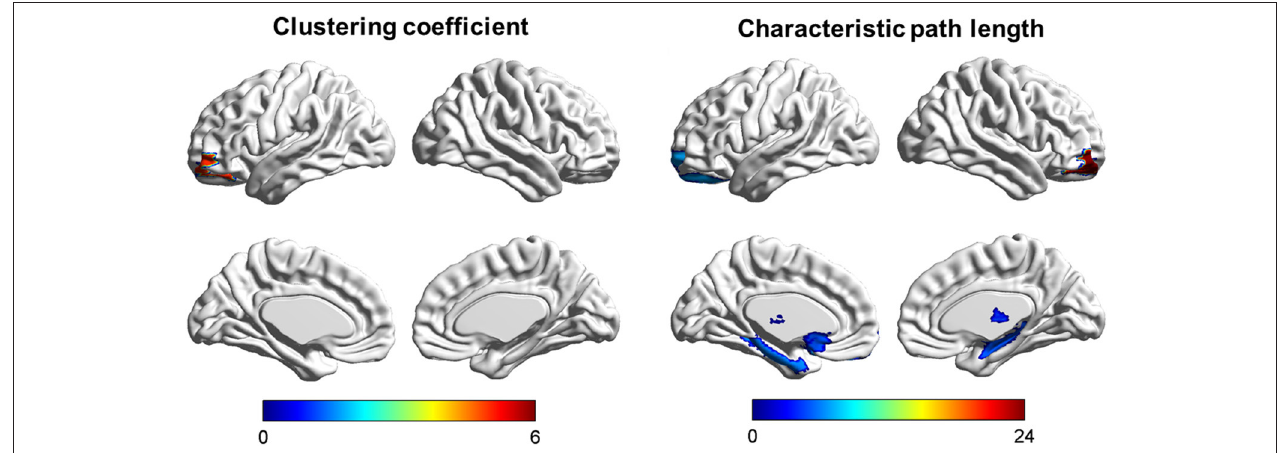
FIGURE 2 | Brain areas showing abnormal segregation and integration among the three groups. Color bar: F -values detected by one-way ANOVA test. P < 0.01 was considered as statistically significant.